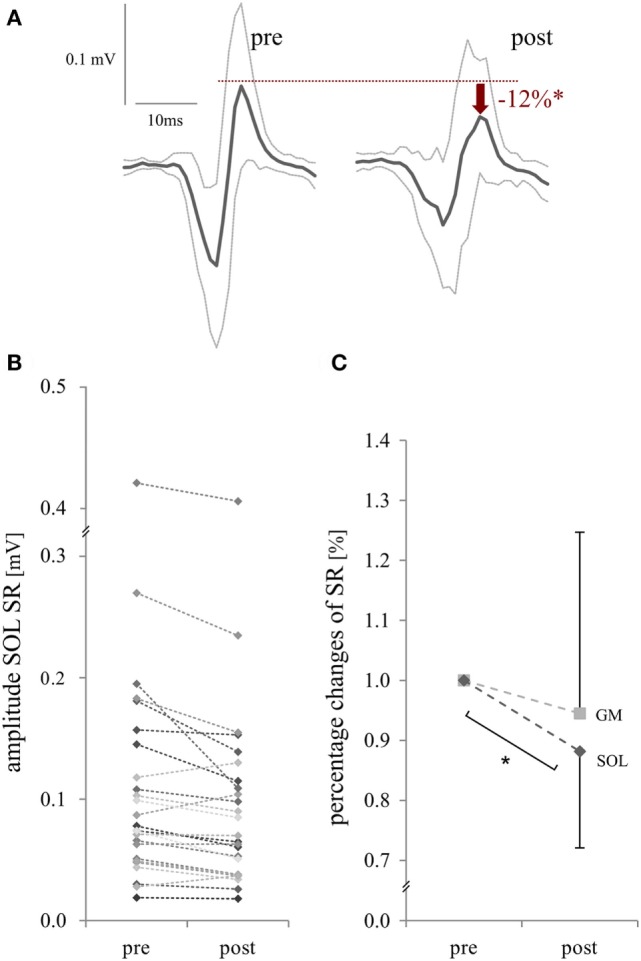
Changes in stretch reflex (SR) excitability in the m. triceps surae, induced by mechanical dorsiflexion of the ankle joint (Protocol 1): representative SR amplitude [m. soleus (SOL)] of a single subject (A), results of each subject [SOL, (B)] and mean values for SR excitability [SOL and m. gastrocnemius medialis (GM), (C)] before (pre) and after whole-body vibration (post). (A,B) Raw values of reflex amplitude and (C) percentage changes for the m. triceps surae are presented. Significant changes (p < 0.05) are illustrated with a * symbol.